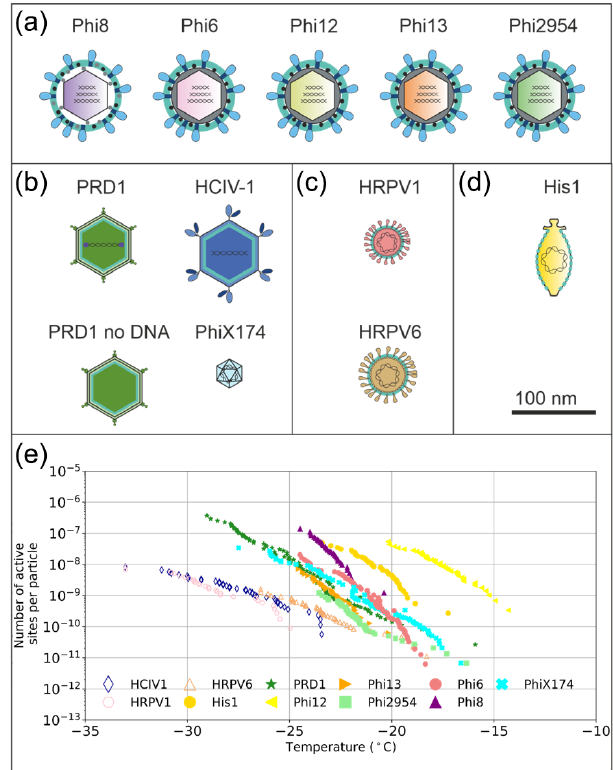
Figure 1. Graphical representation of the virus particles used in the ice nucleation study and their ice-nucleating ability. (a) En- veloped icosahedral viruses. (b) Icosahedral viruses. (c) Pleomor- phic viruses. (d) Lemon-shaped virus. (e) Ice nucleation activity plots (expressed as n n ), where hollow markers indicate limit of detection (LoD) measurements in which the freezing temperatures were consistent with the virus-free saline buffer control. Virus par- ticles are to scale according to the 100nm scale bar. Temperature values have been corrected for freezing point depression of